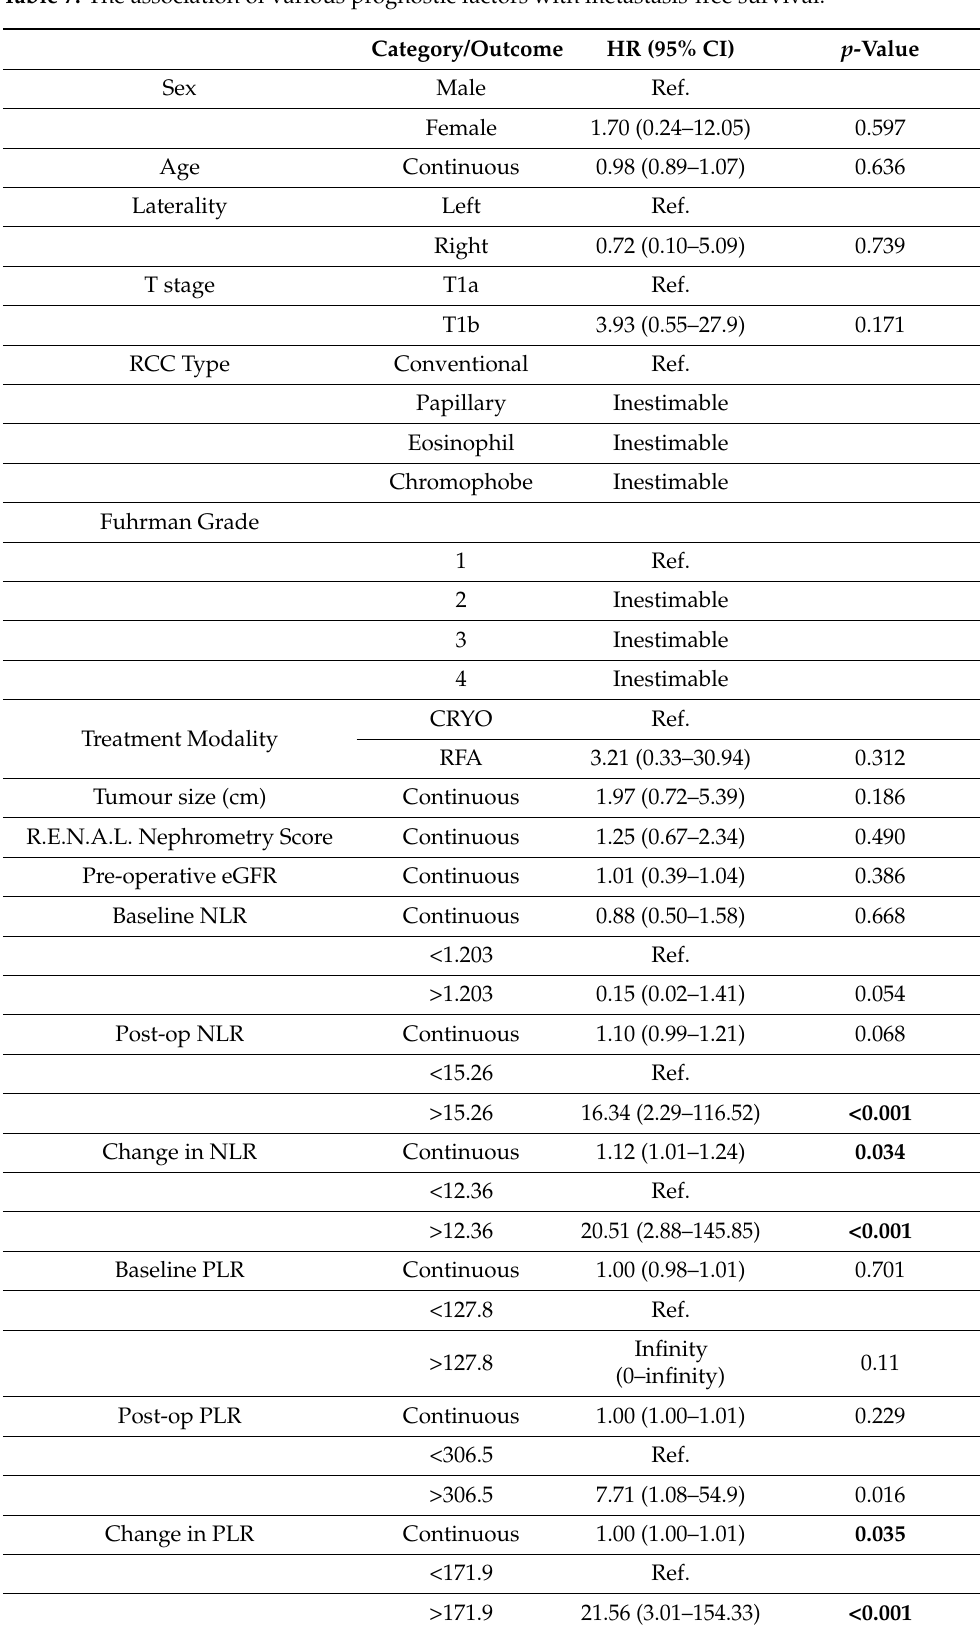
Table 7. The association of various prognostic factors with metastasis-free